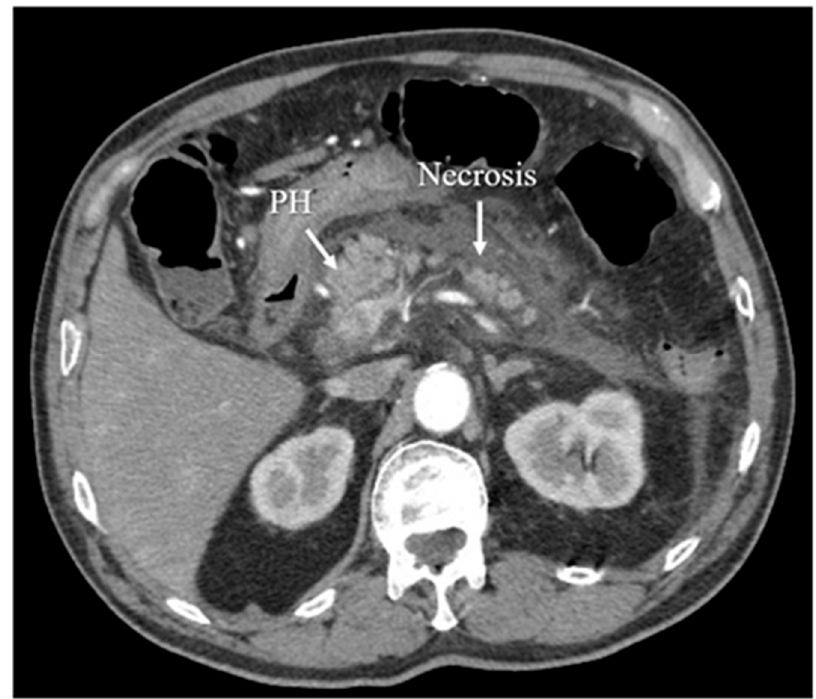
Figure 5. Chronic pancreatitis, with atrophy of pancreatic head (PH) parenchyma and pseudocyst (PC) in this region. The arterial phase of CT.